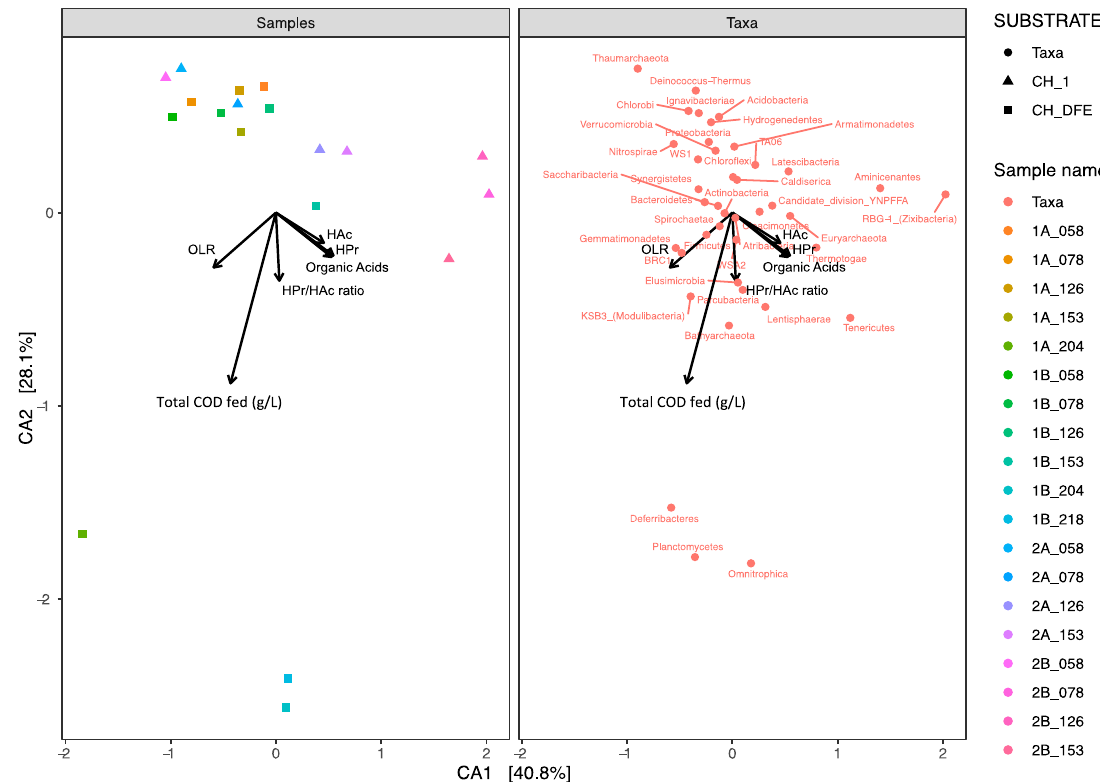
Figure 4. Canonical correspondence analysis (CCA) of amplicon sequence variants (ASVs) at phylum level of the 16S rRNA genes in upflow anaerobic sludge blanket (UASB) reactors 1A and 1B after 58, 78, 126, 153, and 204 days of operation, and in reactors 2A and 2B after 58, 78, 126, and 153 days of operation.